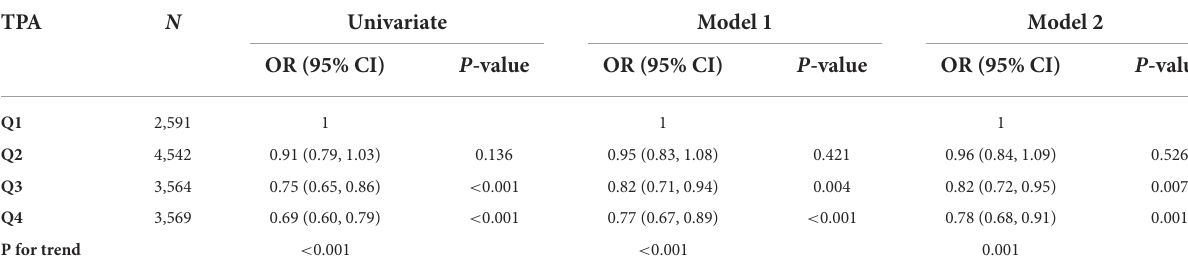
TABLE 2 Logistic regression analysis for the associations between TPA and the risk of hypertension. TPA